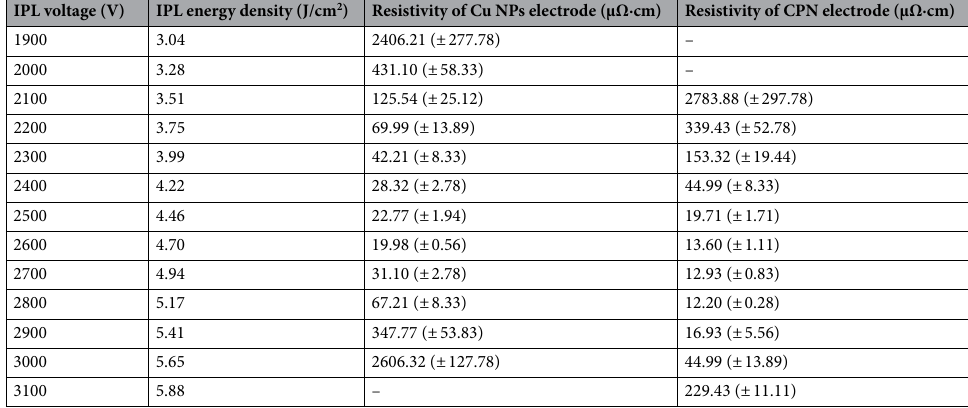
Table 5. IPL energy density with respect to IPL voltage at 3 ms pulse on-time and resistivity of Cu NPs electrode and CPN electrode for each IPL energy